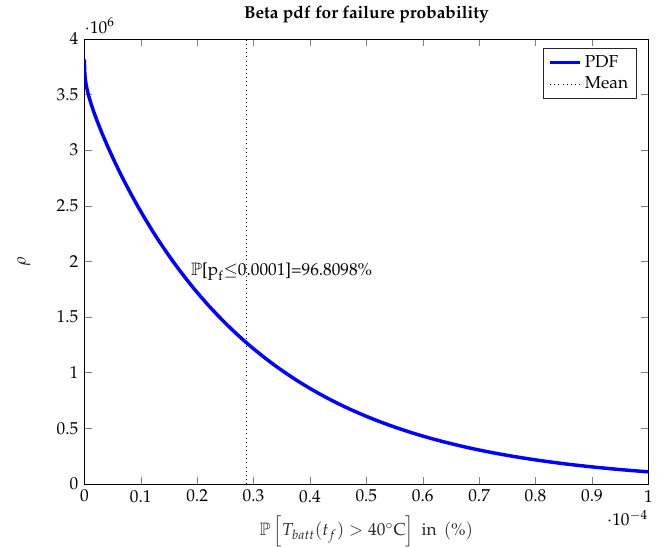
Figure 5. Estimation of failure probability density function from subset simulation for a final point on the optimization time horizon using a Beta distribution with mean value and probability density function area estimation until the allowed failure